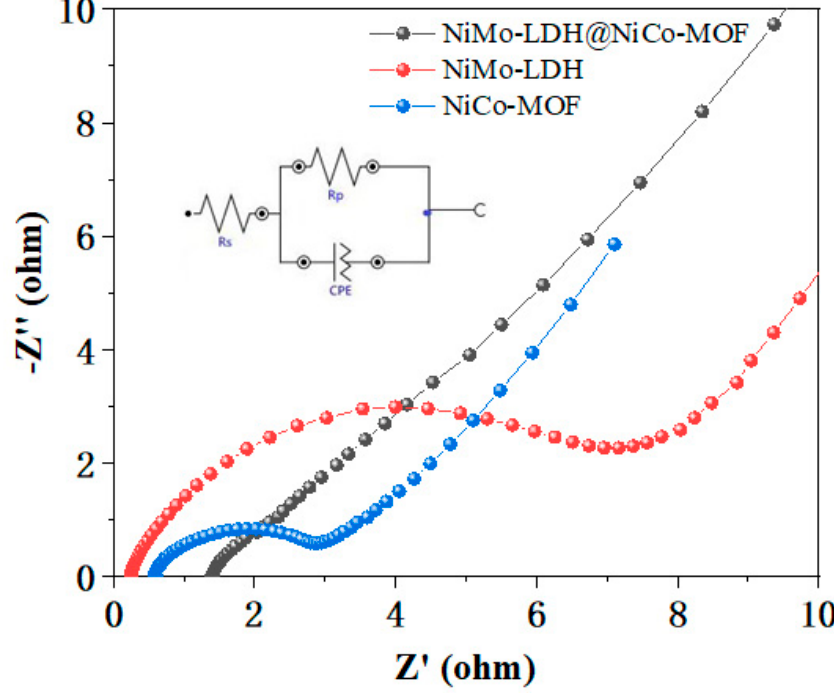
Figure 7. Nyquist plots of NiCo-MOF, NiMo-LDH,